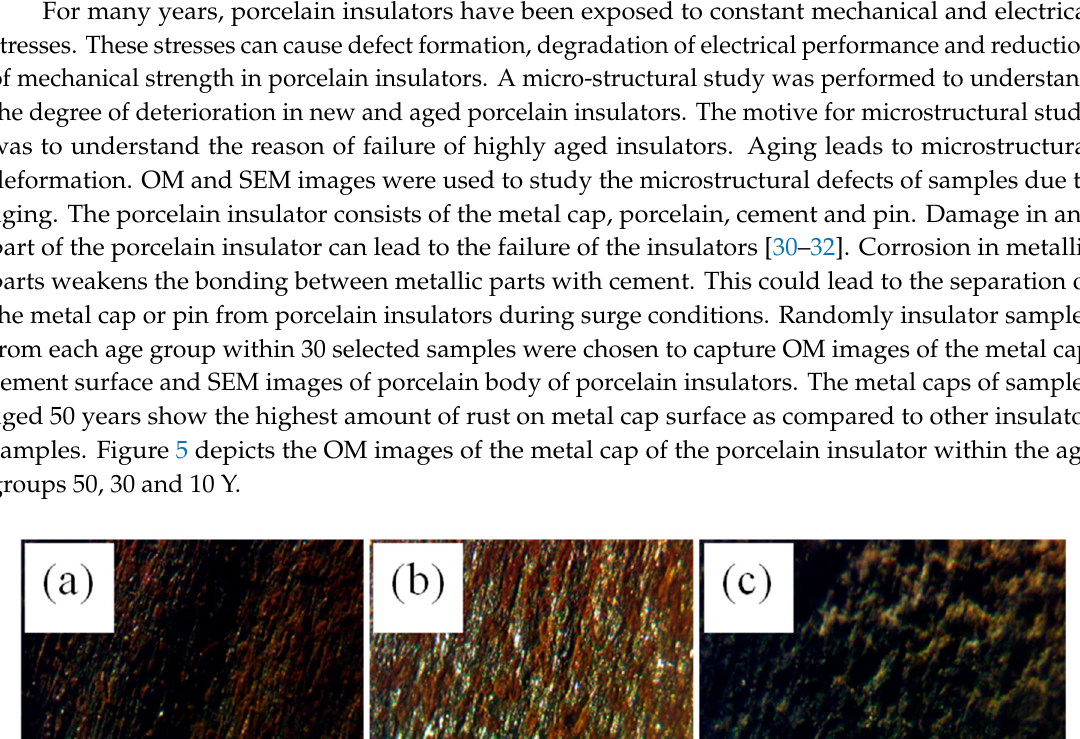
Figure 6. Optical images of cement of porcelain insulators ( a ) 50 years ( b ) 30 years ( c ) 10 years. Figure 7 depicts the OM images of the porcelain-cement interface of three cases of porcelain insulators. In the case of the 50 years sample, there are wide cracks in the porcelain-cement interface, which can lead to detachment of the metal cap and shell during surge conditions. However, insulators spent 30 years of service depicting traces of cracks in the interface. Newly aged insulators that have completedonly 10 years of service did not show any cracks in the porcelain-cement interface.